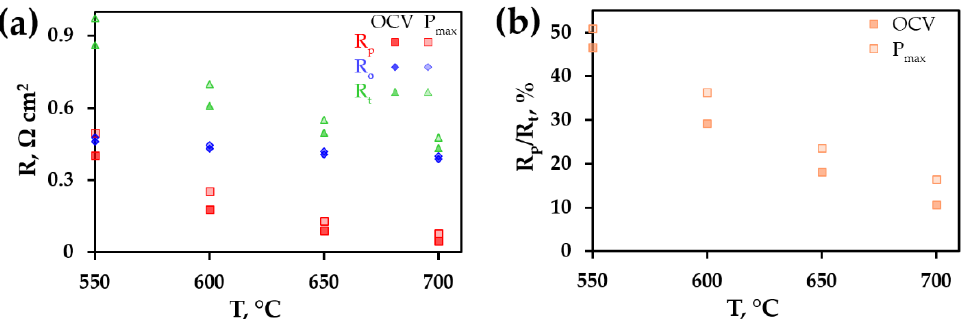
Figure 5. Temperature dependences of R t , R p and R o resistances ( a ) as well as a ratio of R p / R t ( b ) at di ff erent fuel cell conditions (OCV or P max ).